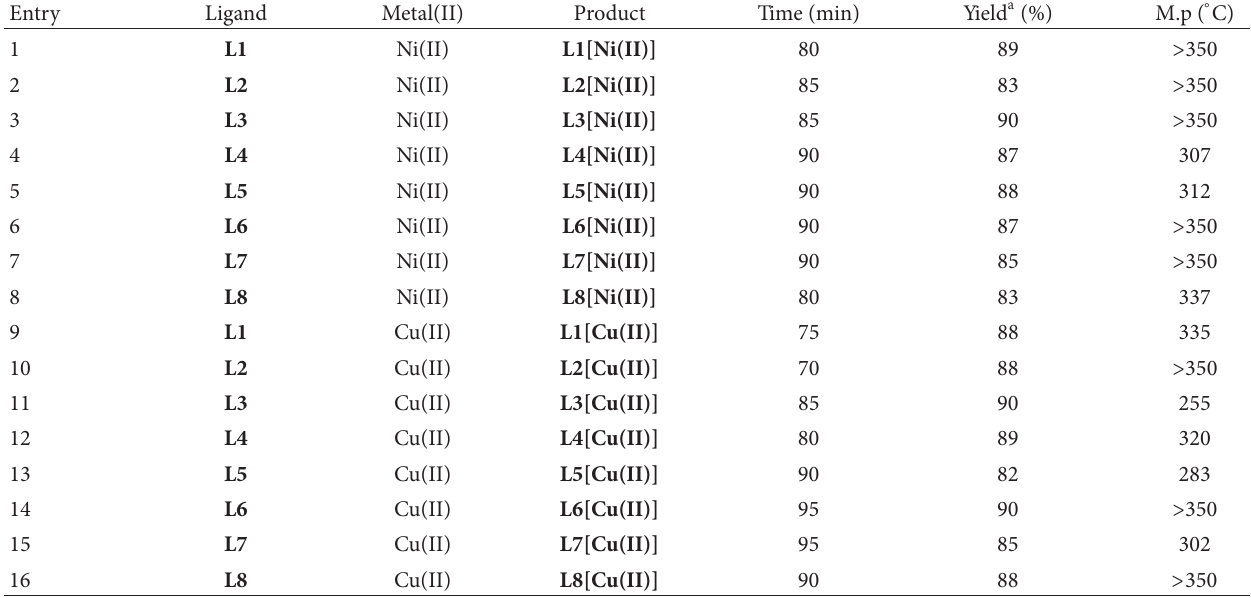
T 2: e results of the reaction for preparation of Schiff base